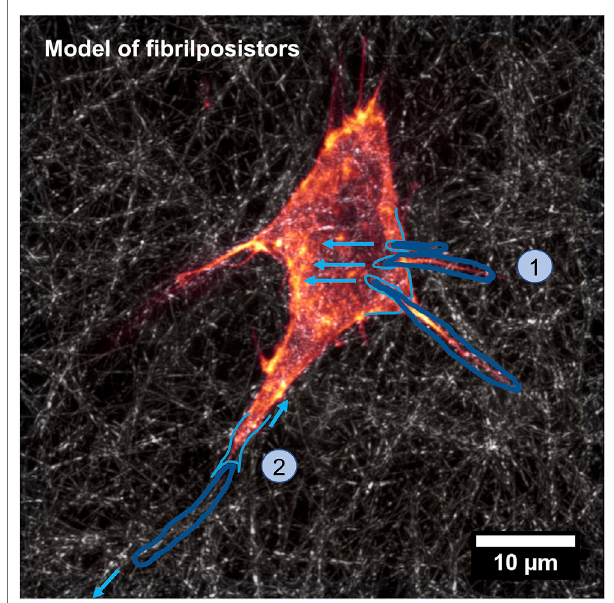
FIGURE 6 | Model of the fi bripositor. A single fi ber is stretched inward due to the tension of the fi bripositor (step 1), which is drawn out of the fi bripositor because of the tension of the extracellular environment (step